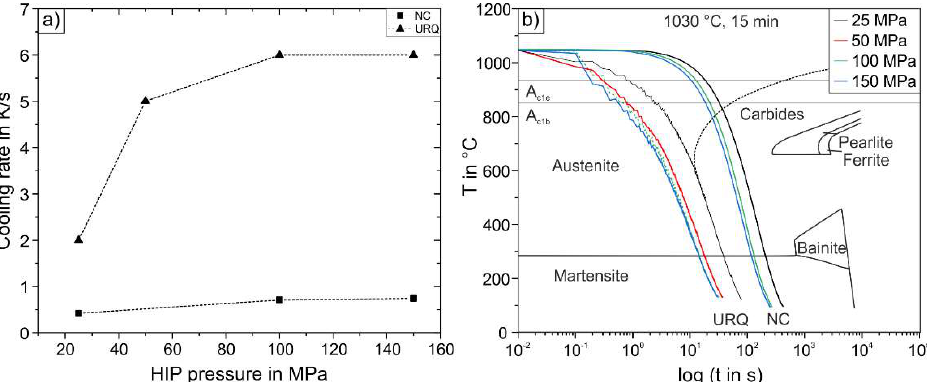
Figure 5. ( a ) Cooling rates achieved inside the HIP unit for different cooling modes (URQ and NC) and pressures and ( b ) cooling curves added to a schematic continuous cooling transformation (CCT) diagram.